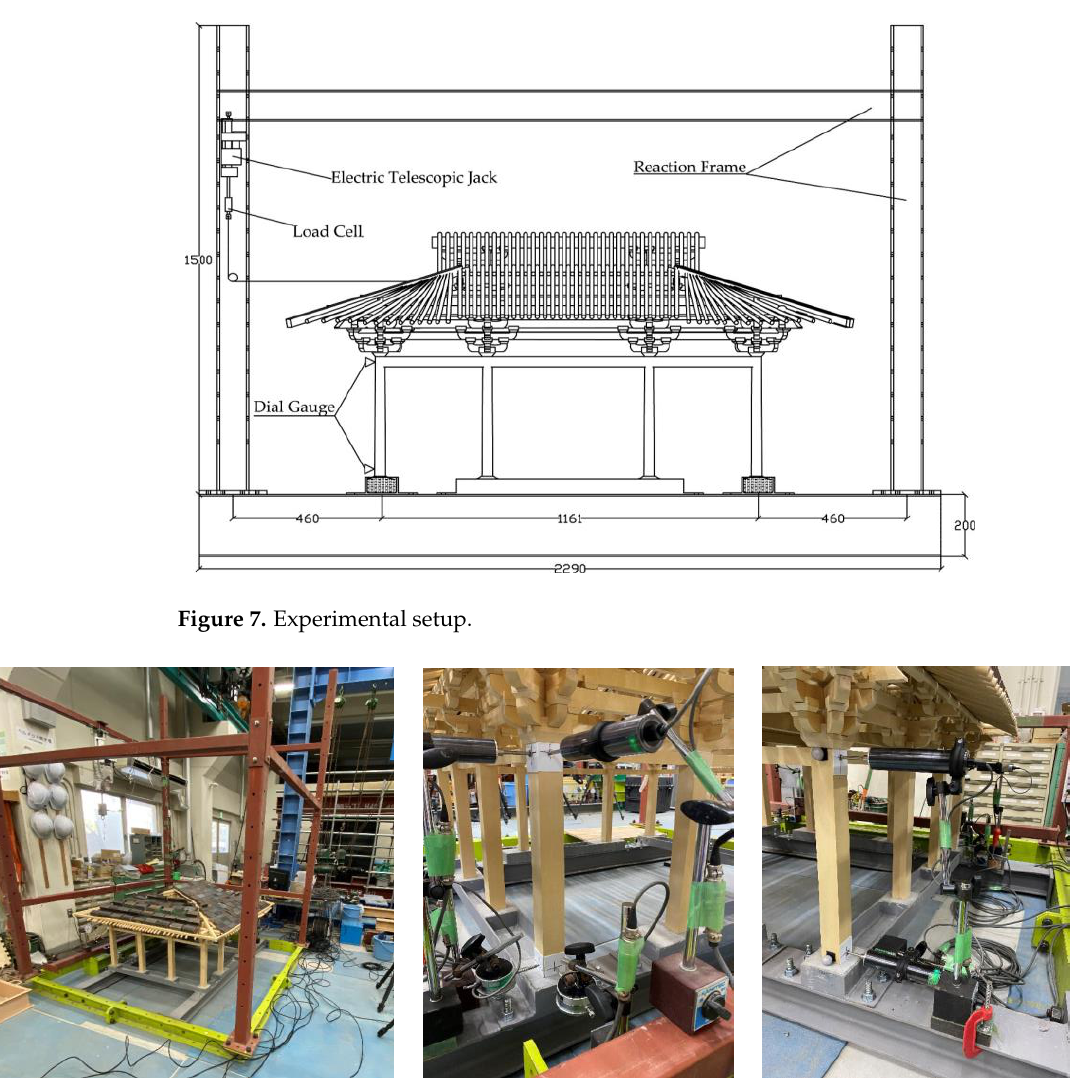
at the head and foot of the column in the frontal and lateral directions to determine the displacement of column. At the end of the horizontal load test, the dial gauge and the electric jack were removed, and the strain gauge (Figure 9a) was tested to ensure correct connection.